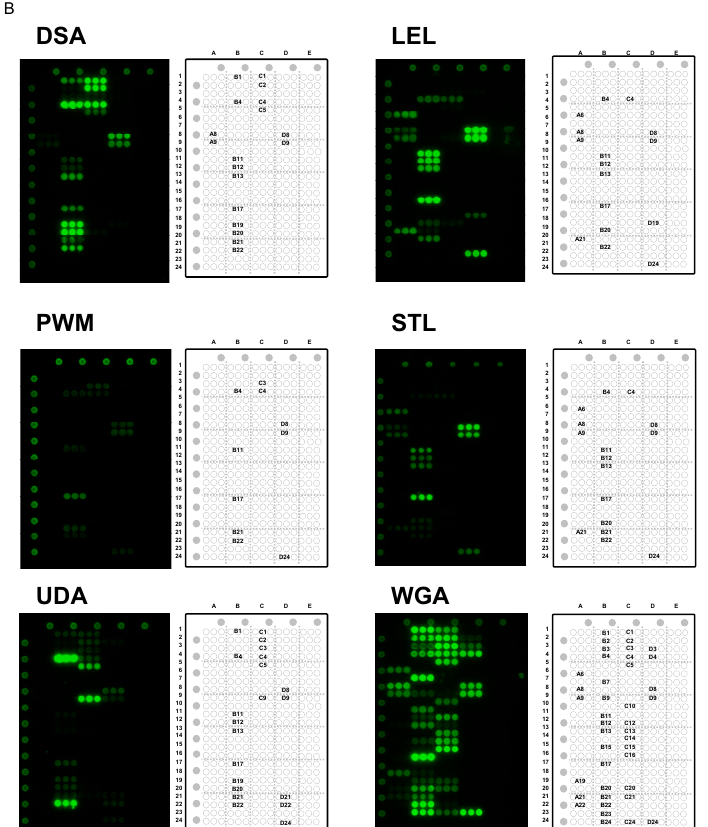
Figure 7. Glycoconjugate microarray analysis to evaluate binding to multivalent glycans. Spot pattern of the glycoconjugate microarray (ver.4.2), where 96 synthetic glycan-conjugated polyacrylamides (PAAs) and glycoproteins were immobilized to a glass slide in triplicate ( A ); BSA (bovine serum albumin) and PAA were included as negative controls. Position markers (Cy3-BSA) were spotted and are depicted as grey-colored closed circle. Signal patterns obtained for each of Cy3-labeled chitin-binding lectins are shown ( B ). For reference, positive signals are abbreviated in the right panel of each fluorescence image.